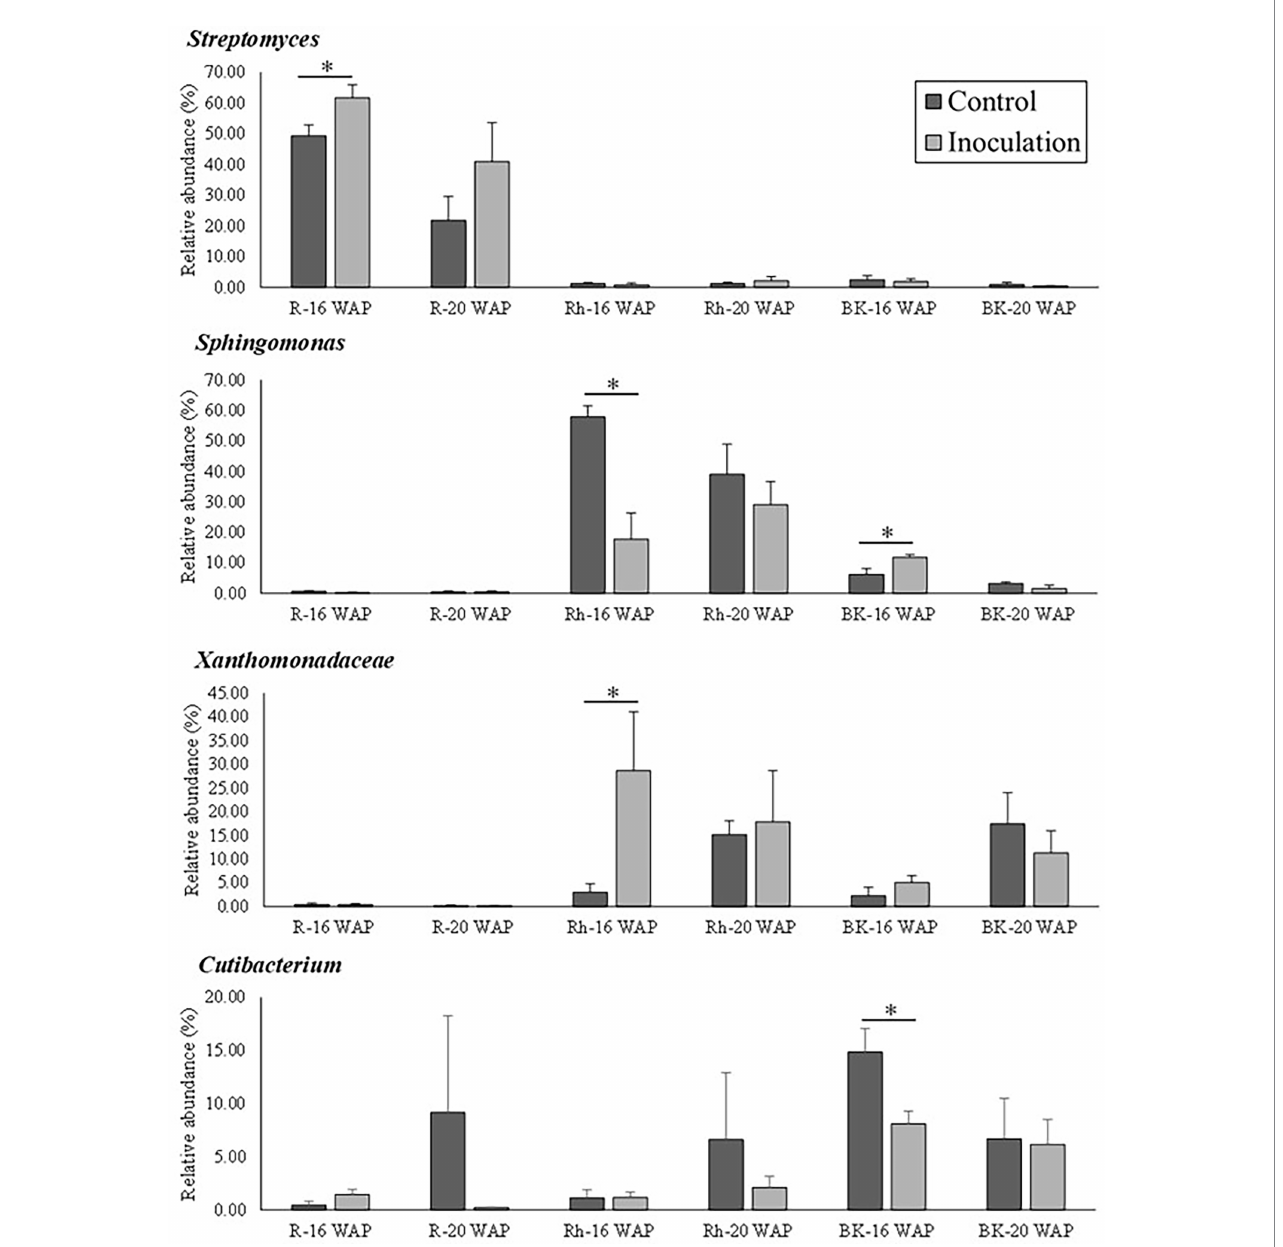
FIGURE 5 Relative abundance of bacteria at the genus/family level between control and inoculation treatment as affected by inoculation with the synthetic bacterial community. Asterisks indicate statistical significance ( p = 0.05) according to a nonparametric Mann-Whitney test. WAP, weeks after planting; R, root; Rh, rhizosphere; BK, bulk